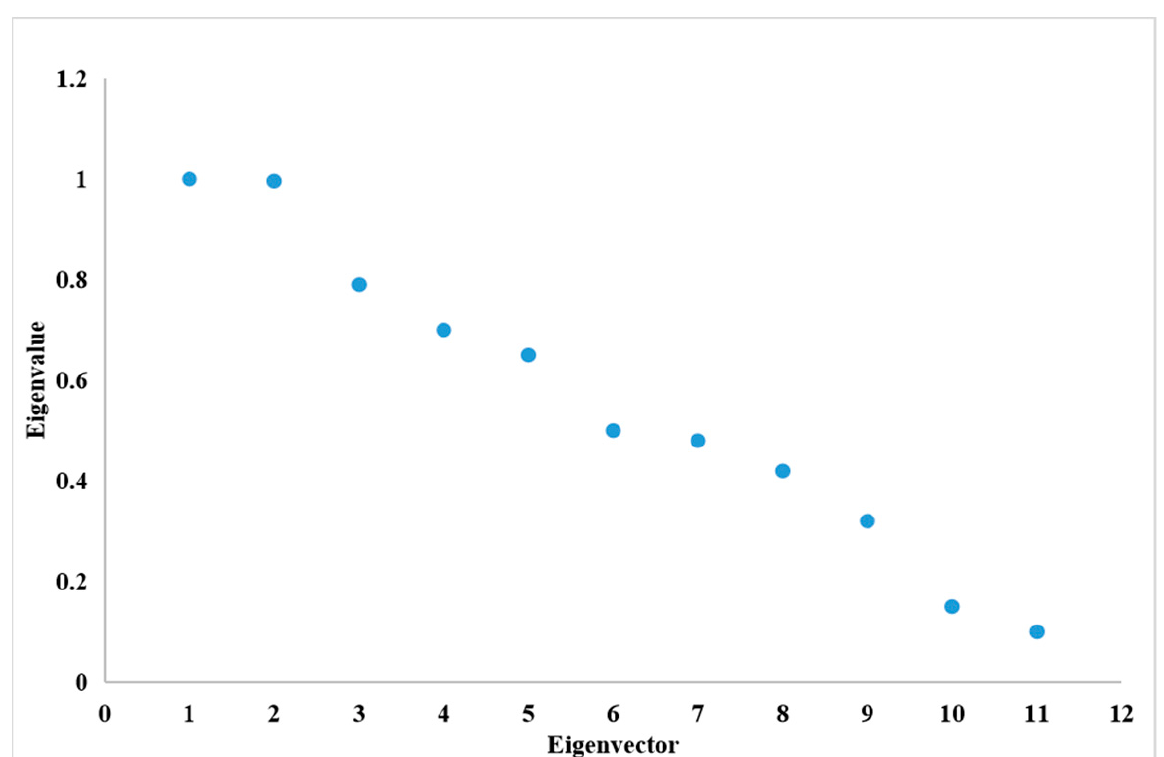
Figure 4. The optimal number of clusters corresponding to the eigenvectors of the Laplacian operator in hepatic encephalopathy. The horizontal axis represents the eigenvectors, and the vertical axis represents the eigenvalues.